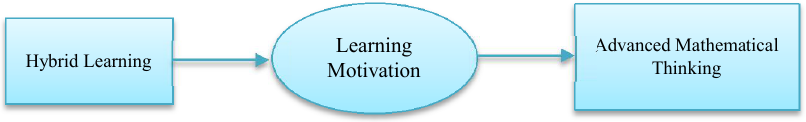
Figure 1. Research of the